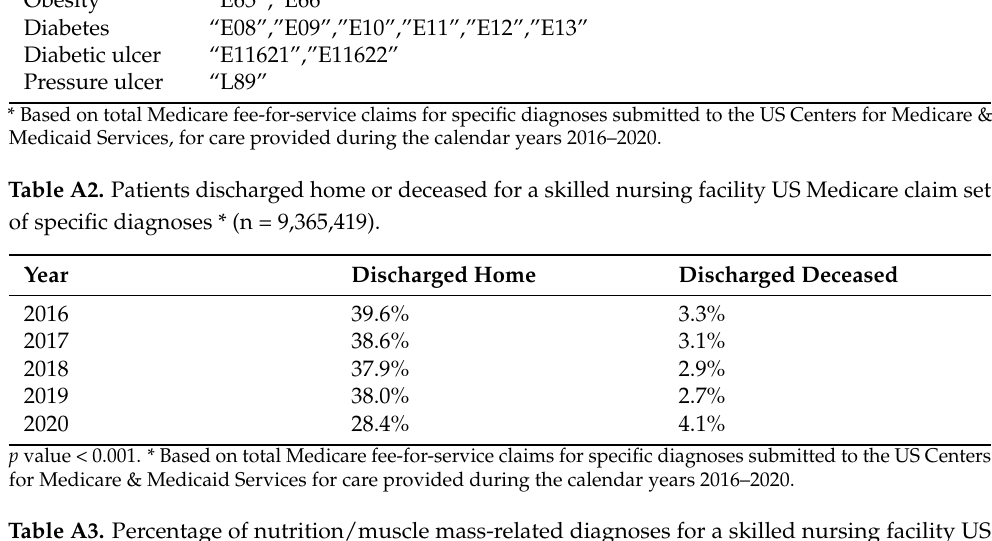
Table A3. Percentage of nutrition/muscle mass-related diagnoses for a skilled nursing facility US Medicare claim set of specific diagnoses * and estimated nursing home prevalence rates of the same